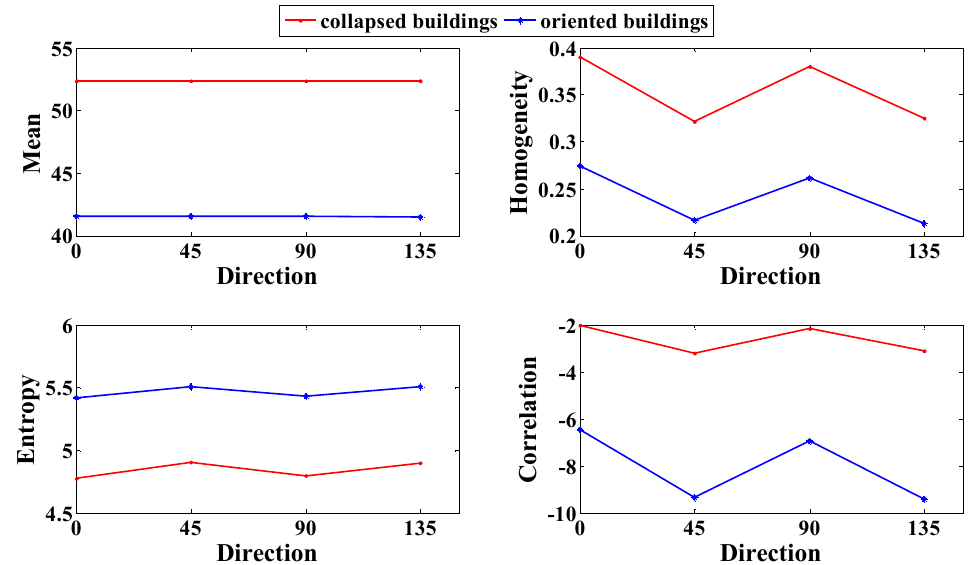
Figure 13. Trend plots of the CB samples and the OB samples at different directions for the four texture features.